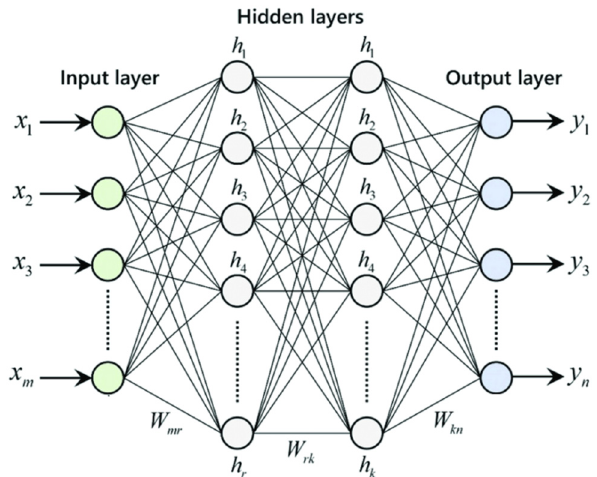
Figure 3: General design of